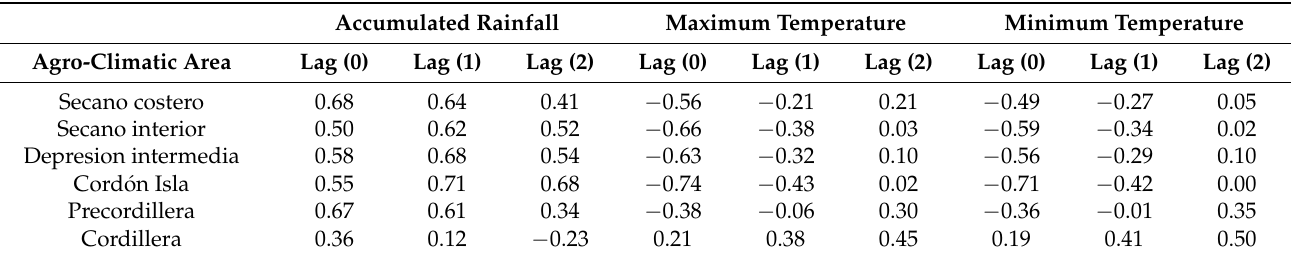
Table 2. Correlation between monthly NDVI with accumulated rainfall, maximum and minimum temperatures at different